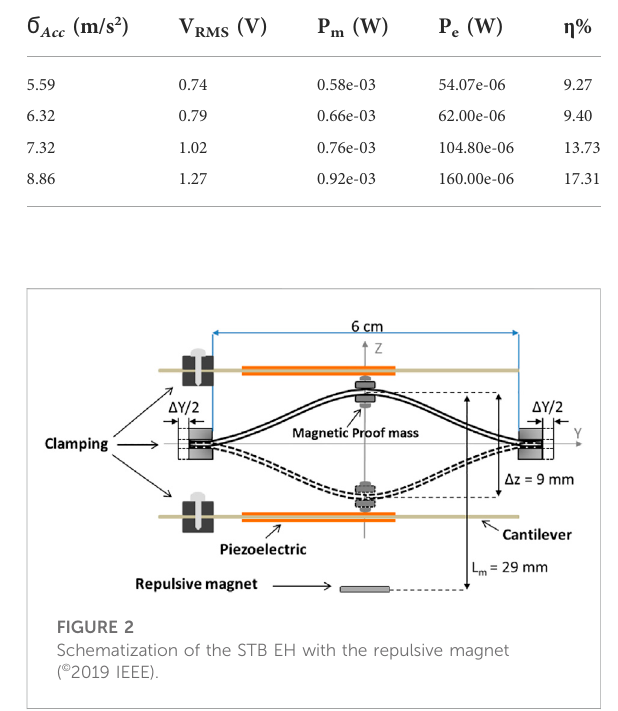
TABLE 3 The standard deviation, ϭ Acc , of the (supra-threshold) acceleration generated by a bandlimited noise input, the RMS piezoelectric output voltage, the mechanical and electrical powers andtheenergyconversionef fi ciencyoftheharvesterdiscussedin[47] ( © 2017 IEEE).